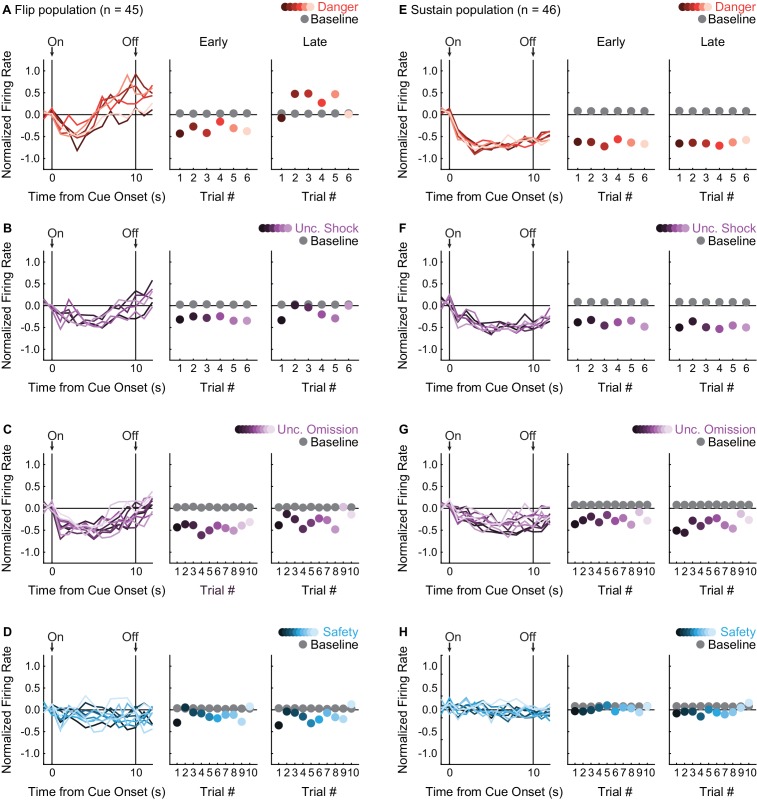
Trial by trial firing for Flip and Sustain populations.(A, left ) Normalized firing rate for the Flip population (n = 45) is shown across cue presentation for each of the six danger trials. Trials are color-coded from dark (first trial) to light (last trial) with ‘On’ indicating cue onset and ‘Off’ indicating cue offset. (A, center) Mean population firing rate for the first 5 s of cue presentation (early) is shown for each trial. Color scheme maintained from A, left. Mean population baseline firing rate (2 s prior to cue presentation) is shown for each trial (gray). (A, right) Firing for the last 5 s of cue presentation (late) shown as in A, center. Identical figures using unique color schemes were made for each trial type: (B) uncertainty shock, (C) uncertainty omission and (D) safety. An identical set of figures were made for the Sustain population (n = 46; E–H).